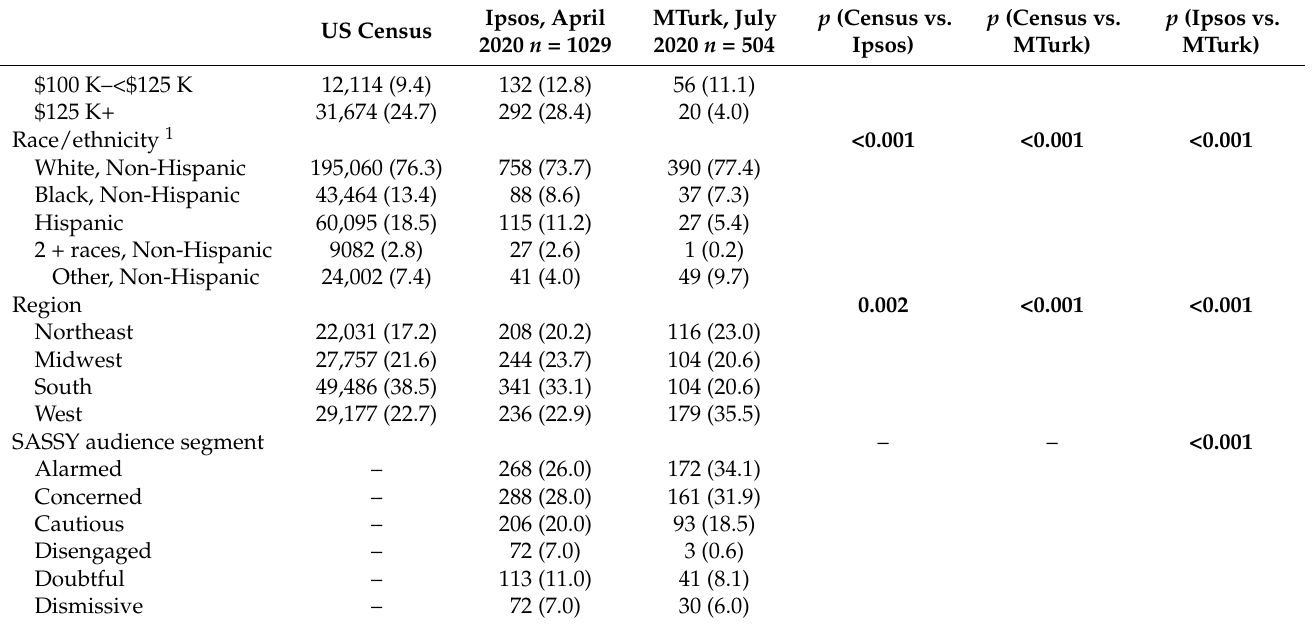
Table 2. Demographic similarities and differences across SASSY Segment in the MTurk sample, n = 504 .